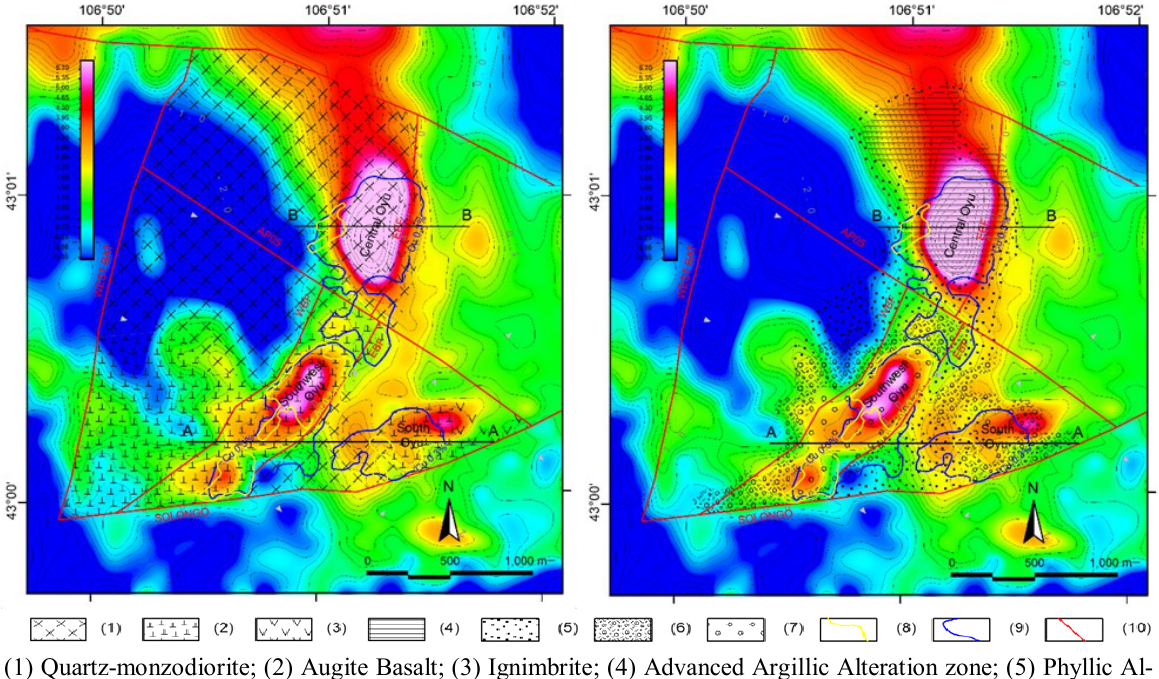
(1) Quartz-monzodiorite; (2) Augite Basalt; (3) Ignimbrite; (4) Advanced Argillic Alteration zone; (5) Phyllic Al- teration zone; (6) Prophyllitic Alteration zone; (7) Potassic Alteration zone; (8) Gold Grade isoline – 0.3 ppm; (9) Copper grade isoline – 0.3%; (10) Faults Fig. 8. Summary geophysical response map: map overlapping with lithology (left), map overlapping with alteration zones